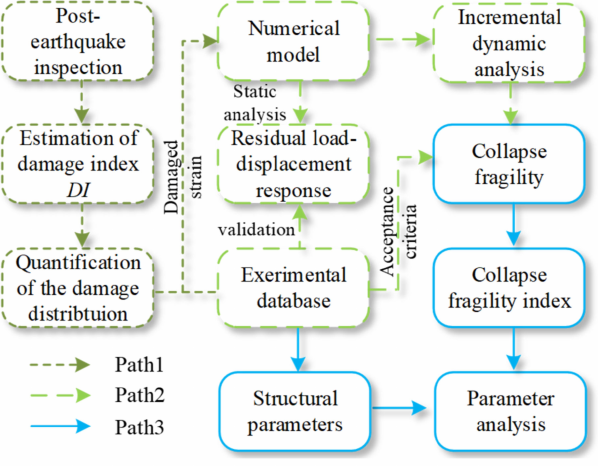
Figure 1. Overview of the